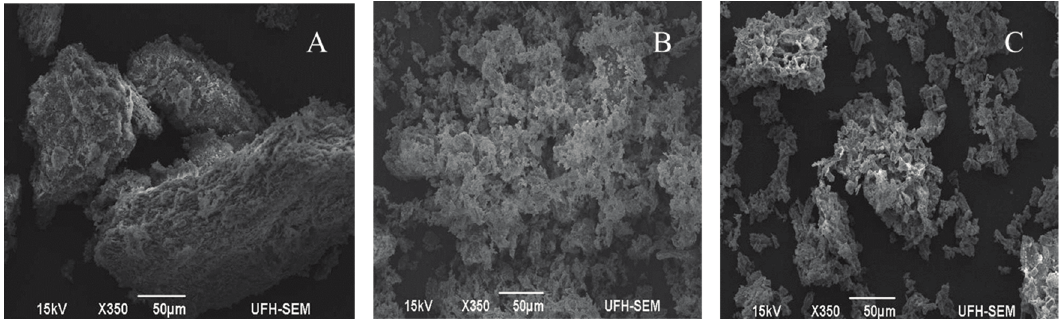
Figure 8. SEM images of REG-6 ( A ); kaolin clay particles ( B ) and kaolin clay suspension flocculated with REG-6 ( C